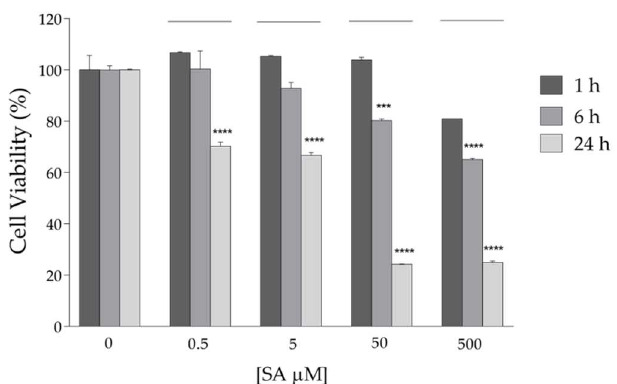
Figure 6 . HaCaT cells viability measured after the treatment of cells with increasing concentration of SA at three different incubation time (1, 6 and 24 h). Experiments were performed in triplicate and statistical analysis were carried out by using GraphPad Prism. Values are the means ± SEM of biological replicates (*** p < 0.001 or **** p < 0.0001) compared to the respective controls (one-way ANOVA, followed by Bonferroni’s post-test).